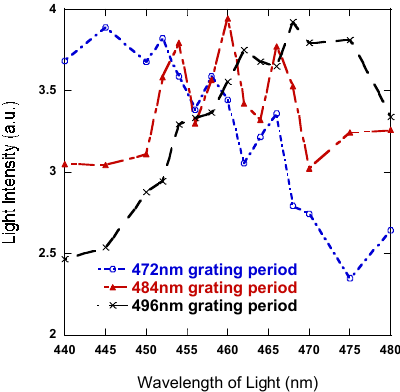
Figure 10. Light extraction intensity across the LED emitting spectrum.